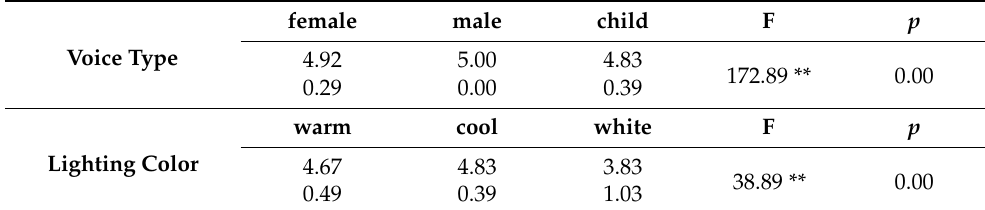
Table 4. Results of the manipulation